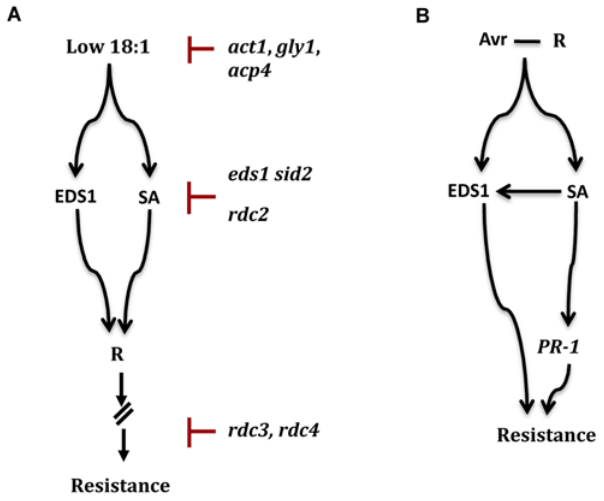
Figure 9. Models for signaling induced by low 18:1 fatty acid levels and R genes. (A) EDS1 and SA function upstream of R genes and regulate expression of R genes induced by low 18:1 fatty acid levels. Mutations in EDS1 and SA-synthesizing enzyme, encoded by SID2 , abolish constitutive upregulation of R genes and associated enhanced resistance in genetic backgrounds containing low 18:1 levels. Similar to EDS1/SA, restored in defective crosstalk ( RDC ) 2 acts downstream of signaling induced by low levels of 18:1 but upstream of R gene expression. Signaling induced by low 18:1 fatty acid levels can also be suppressed by mutations in ACT1 -encoded G3P acyltransferase [30], GLY1 -encoded G3P dehydrogenase [31], or ACP4 -encoded acyl carrier protein 4 [35], which normalize 18:1 levels, or by blocking steps downstream of R gene expression ( rdc3 and rdc4 ). Upregulation of R genes induced by low 18:1 fatty acid levels does not require PAD4 , SAG101 , or EDS5 , which are components of the resistance signaling pathway(s) initiated upon R-Avr interaction. (B) Direct or indirect interaction between host-encoded R and pathogen-encoded Avr products initiate resistance signaling, which requires EDS1 and SA. Exogenous application of SA induces expression of PR-1 and EDS1 genes but overexpression of EDS1 does not induce PR-1 expression or increase SA levels. The EDS1– and SA–dependent pathways have additive